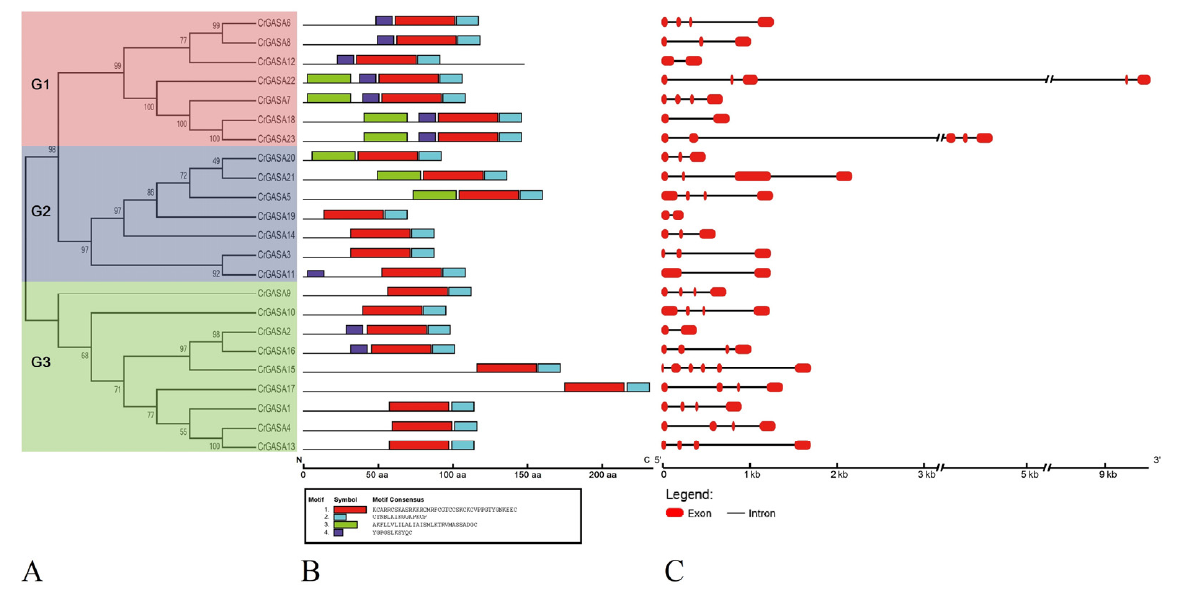
Figure 4. Structural analysis of the CrGASA proteins and genes. ( A ) The phylogenetic tree constructed using MEGA 6.0. The three major groups are marked with different background colors. ( B ) The conserved motifs of each group identified by the MEME web server. Different motifs are represented by different colored boxes, and the motif sequences are provided at the bottom. ( C ) The exon–intron organization of the CrGASAs constructed using GSDS 2.0.